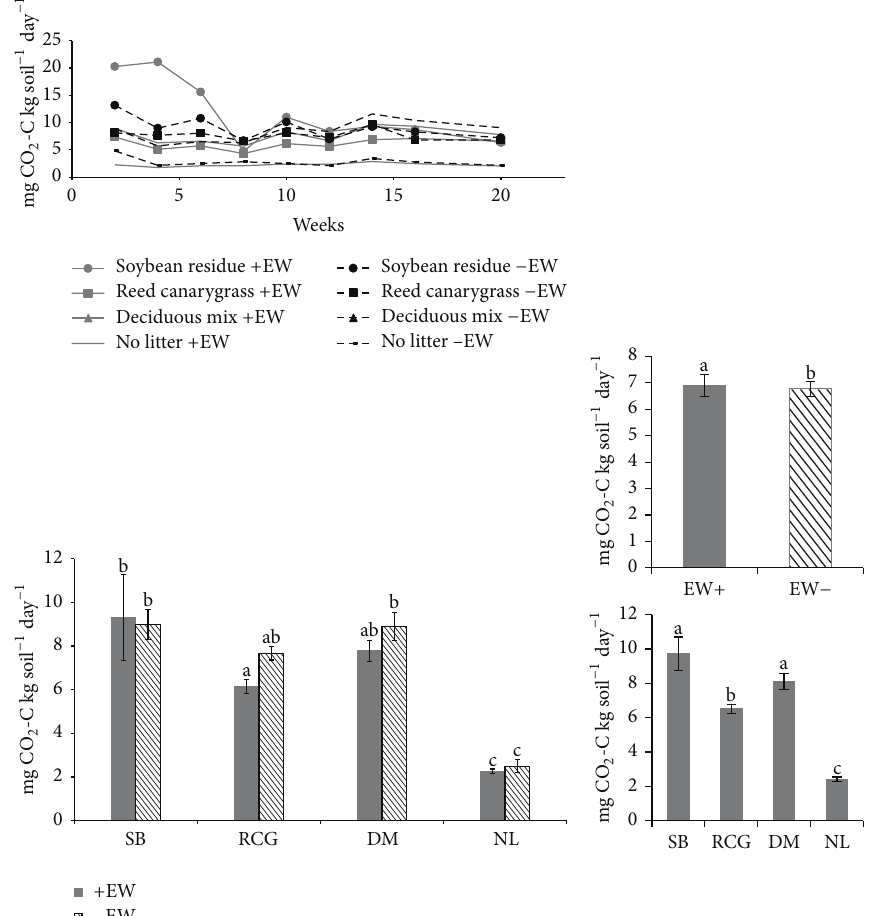
Figure 1: Mean CO 2 fluxes over time from each treatment combination (litter × earthworm) from microcosms with riparian soil over 20 wks. Bar graphs indicate mean CO 2 fluxes averaged from nine sampling dates, according to litter × earthworm treatments ( 𝑛 = 36 ), earthworms ( 𝑛 = 144 ), and litter effects ( 𝑛 = 60 ). Litter treatments are labeled according to no litter (NL), soybean (SB), reed canarygrass (RCG), or deciduous-mix litter (DM). Error bars represent the standard error of the mean. Lower-case letters (a, b, and c) represent differences due to the litter × earthworm interaction ( 𝑃 < 0.05 , Kruskal-Wallis